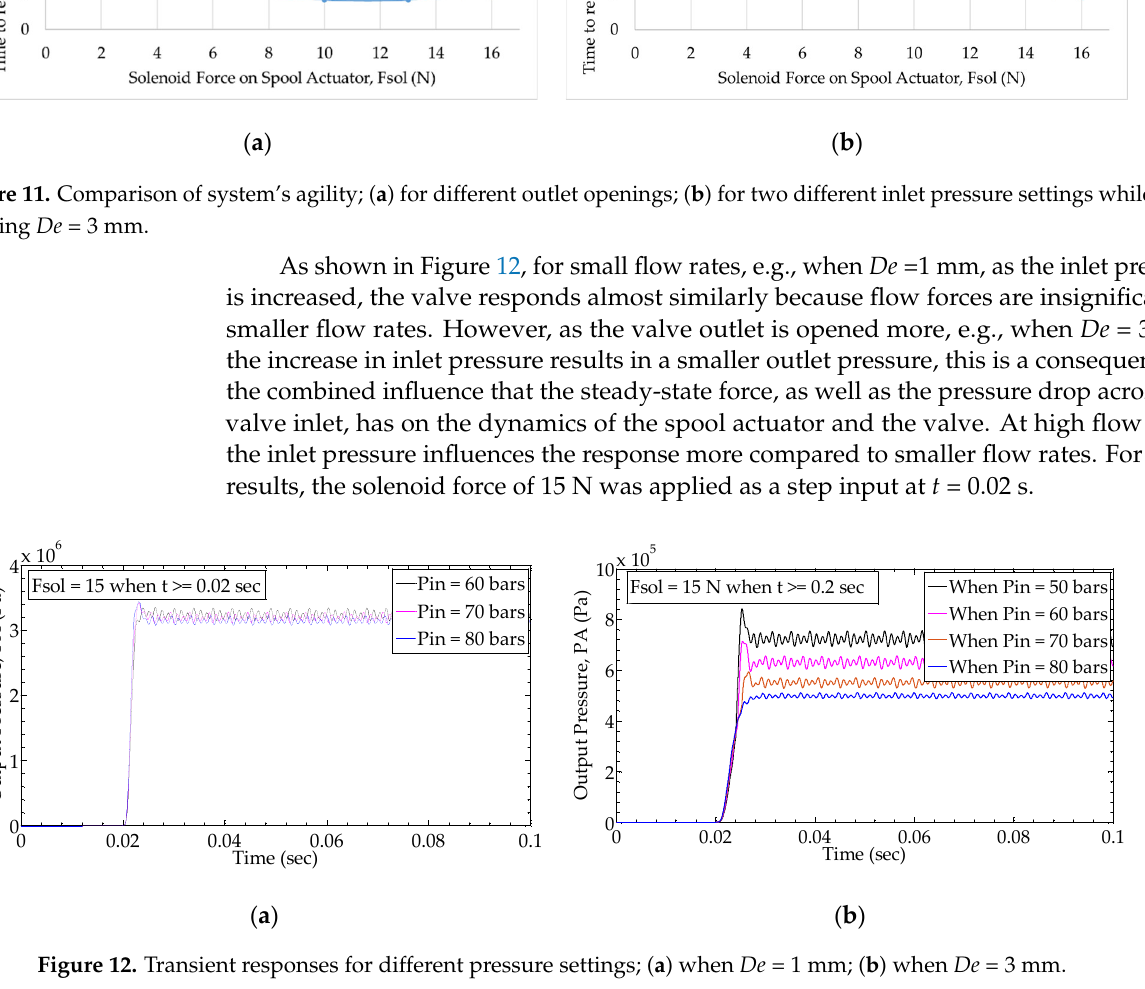
Figure 13. Steady-state output pressure for different values of orifice size and solenoid force. Figure 14. Transient response of output pressure for different values of orifice size.